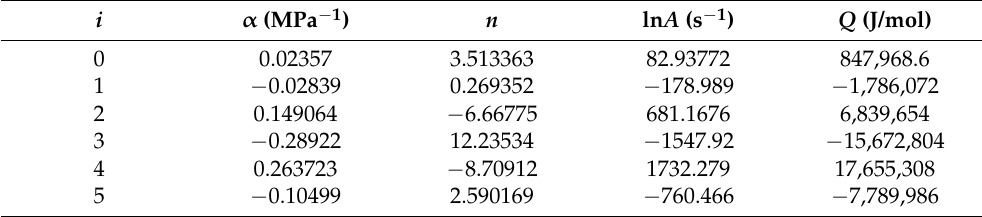
Figure 6. Variation of ( a ) α , ( b ) n , ( c ) ln A , and ( d ) Q with true strain using 5th polynomial fit. Table 2. The material parameters of TA31 for the Arrhenius-type model by regression method.